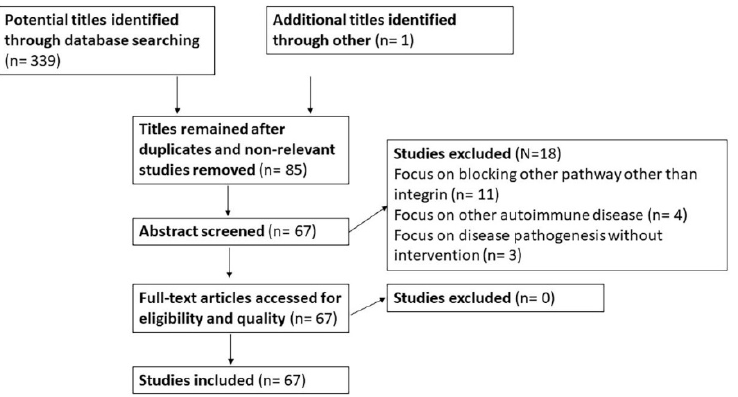
Figure 1. A PRISMA flow diagram depicting information through the different phases of this